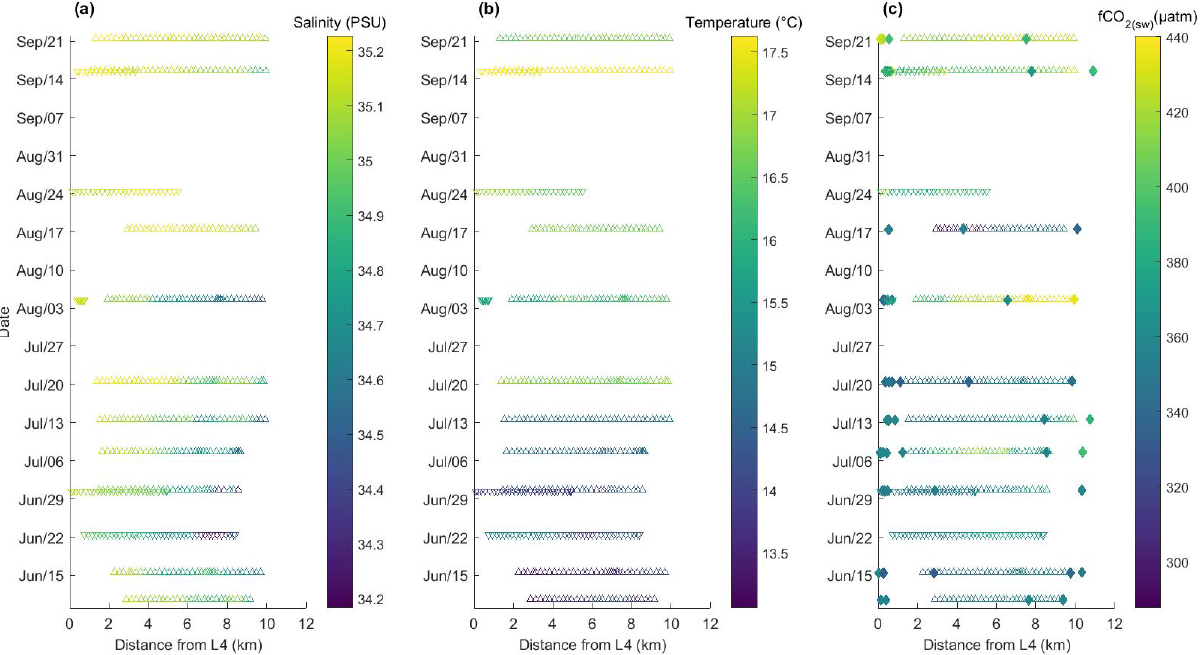
Figure 3. Surface water transects by RV Plymouth Quest between Plymouth Breakwater and station L4 from 10 June to 21 September 2016. Plotted are (a) salinity, (b) temperature and (c) f CO 2 as a function of distance from L4. Outbound transects are shown as downwards triangles, and inbound transects are shown as upwards triangles for salinity, temperature and membrane equilibrator f CO 2 (sampling period = 0.5min). Showerhead equilibrator f CO 2 observations are denoted by filled